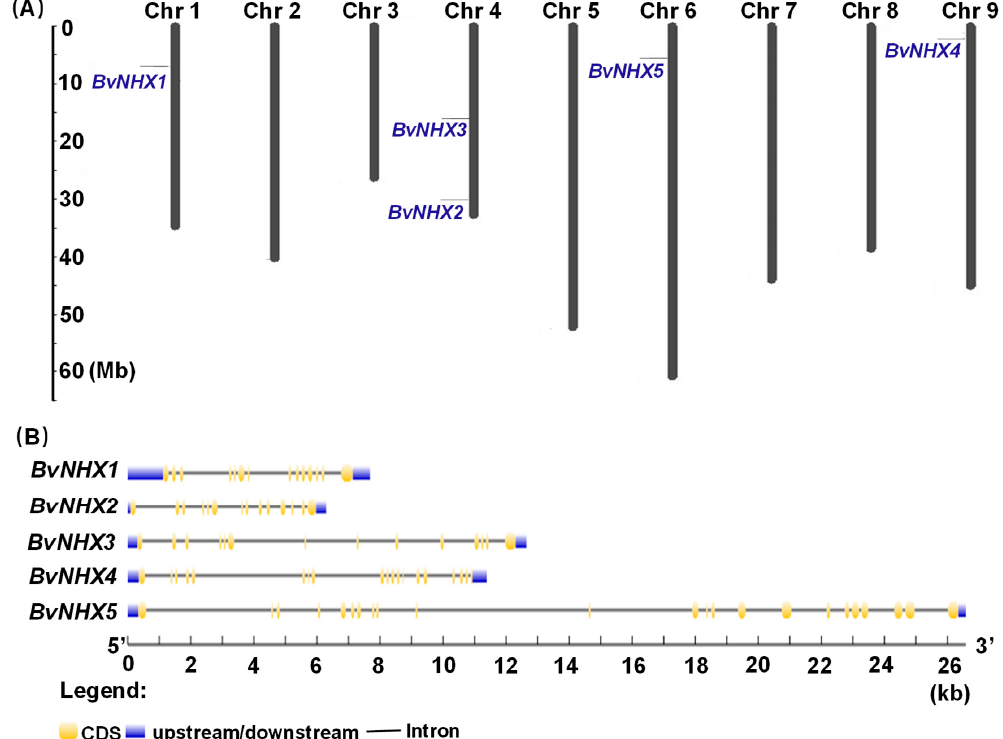
Figure 2. Physical mapping and structure analysis of the BvNHX gene. ( A ) The distribution of the BvNHX genes of sugar beet on 9 chromosomes. The number of chromosomes is shown at the top of each chromosome. The numbers of BvNHX genes are indicated on the left of each chromosome. The scale of the genome size is given on the left. ( B ) Gene structures of the BvNHX genes. Exons are indicated by yellow boxes. Introns are indicated by black lines. Upstream and downstream are indicated by blue boxes. The scale of genes length is given at the bottom. CDS: Coding sequence; Mb: million bases; kb: kilo bases.